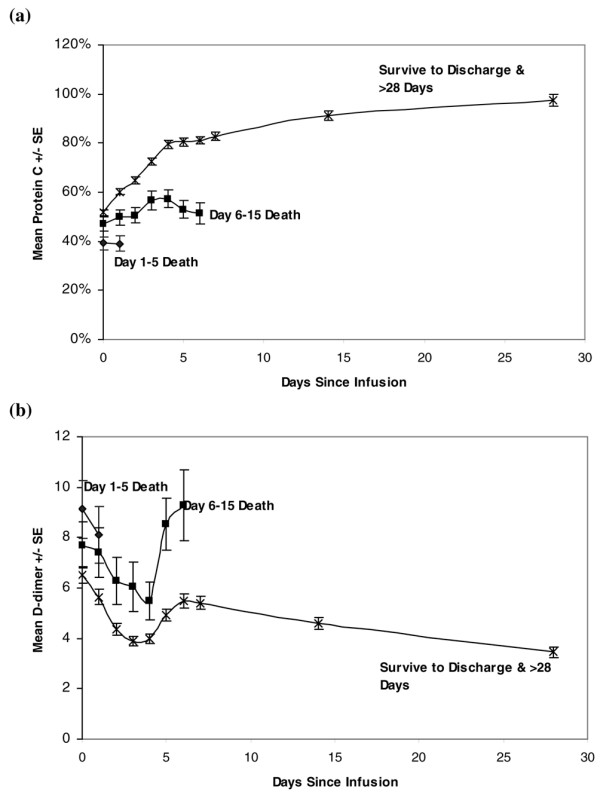
PC and d-dimer levels. Shown are the mean ± standard error (a) protein C (PC) and (b) d-dimer levels based on time of death. Raw values with no imputation were included. PROWESS (Recombinant Human Activated Protein C Worldwide Evaluation in Severe Sepsis) drotrecogin alfa (activated; DrotAA) patients with baseline measures were classified according to timing of death (n = PC/d-dimer): death ≤ 5 days after start of infusion (n = 79/86); death after 6 to 15 days (n = 81/84); and survival to day 28 and hospital discharge (n = 544/577). The PC data were reported by Vangerow and coworkers [42] and comparable PC data for PROWESS placebo patients were reported by Macias and Nelson [22].